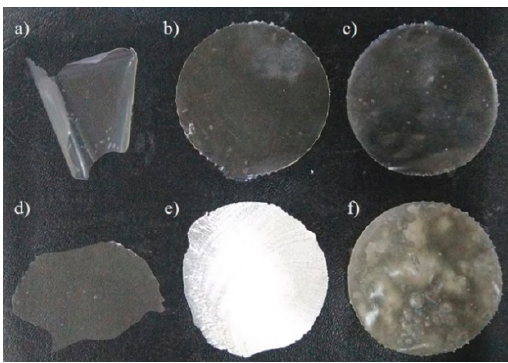
Figure 2. Protein films of jumbo squid ( Dosidicus gigas ), control (squid protein only) ( a ); glycerol ( b ); sorbitol ( c ); mannitol ( d ); maltitol ( e ) and xylitol ( f ).